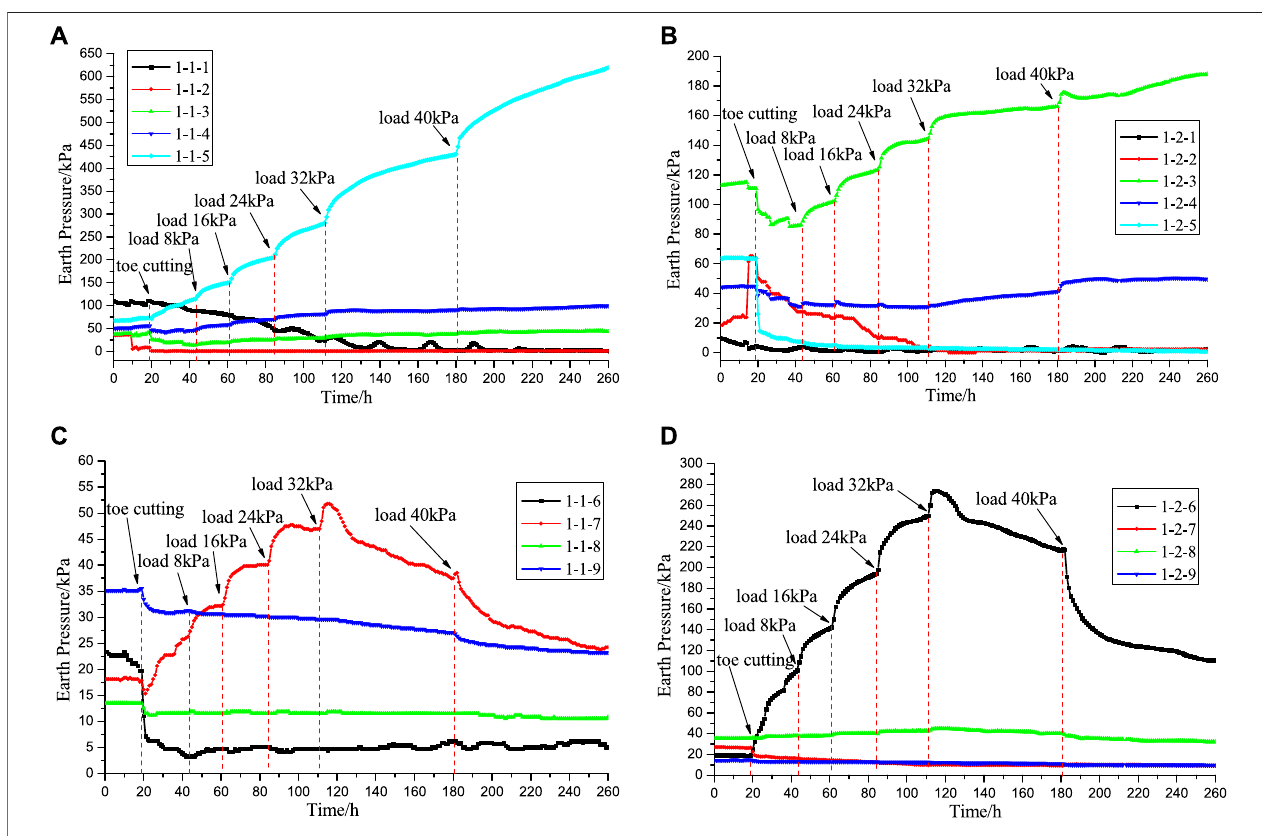
FIGURE 7 | Earth pressure measured in front of and behind pile D4: (A) earth pressure in front of the anti-sliding segment of pile D4, (B) earth pressure behind the anti-sliding segment of pile D4, (C) earth pressure in front of the anchoring segment of pile D4, and (D) Earth pressure behind the anchoring segment of pile D4.